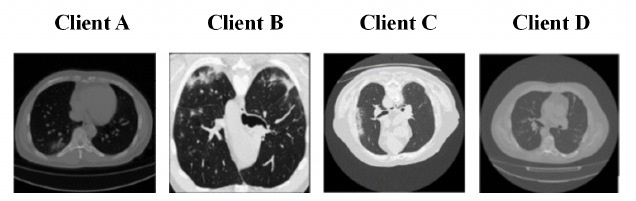
Figure 4. Examples of COVID-19 images from four clients showing considerable statistical hetero-